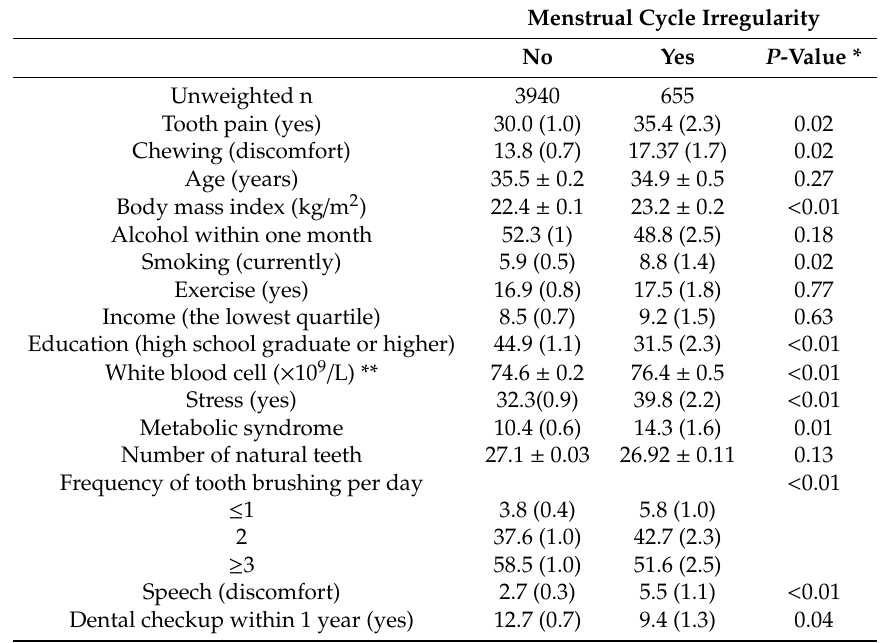
Table 1. Baseline characteristics of study participants according to menstrual cycle irregularity.